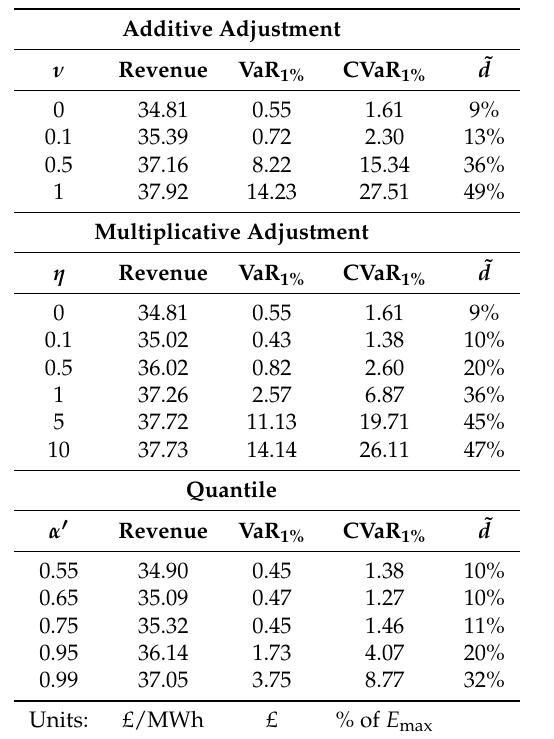
Figure 2. Plots of revenue vs. risk and imbalance volume for the three risk-constrained strategies with parameter values spanning those listed in Table 3. Crosses indicate the results from the revenue-maximising (zero/max) and imbalance minimising strategies tabulated in Table 2. Table 3. Performance of the risk-constrained offer strategies. The case ν , η = 0 is equivalent to offering a volume equal to the wind power forecast (imbalance minimisation), the additive adjustment strategy with ν = 1 is equivalent to offering